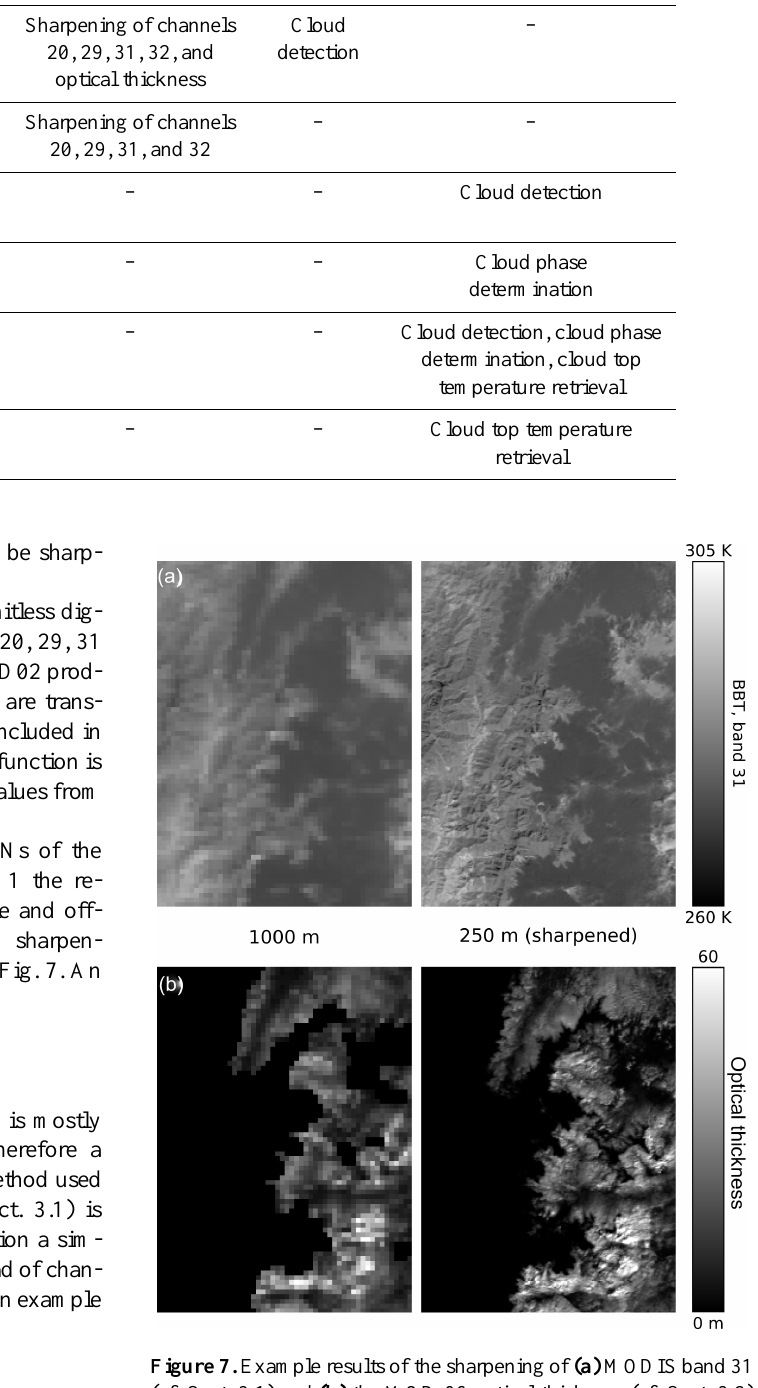
Figure 7. Example results of the sharpening of (a) MODIS band 31 (cf. Sect. 3.1) and (b) the MOD 06 optical thickness (cf. Sect. 3.2) for the MODIS overflight on 5 January 2014 at 10:35UTC +